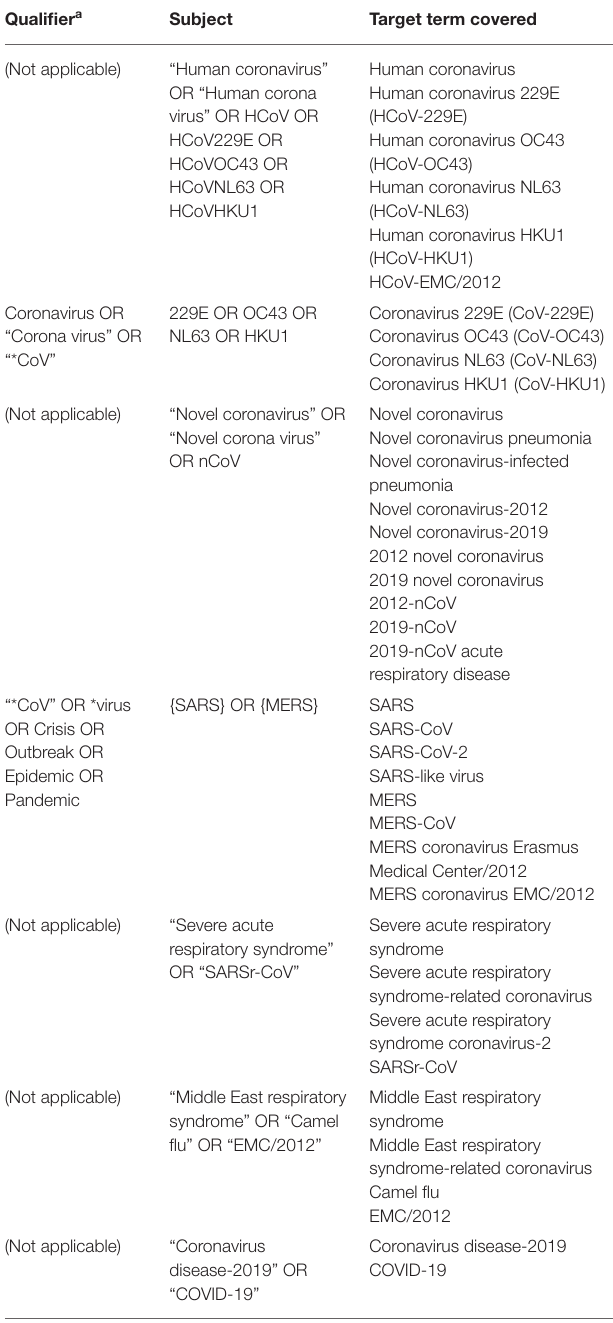
TABLE 1 | Collocation of qualifiers and subjects in the search